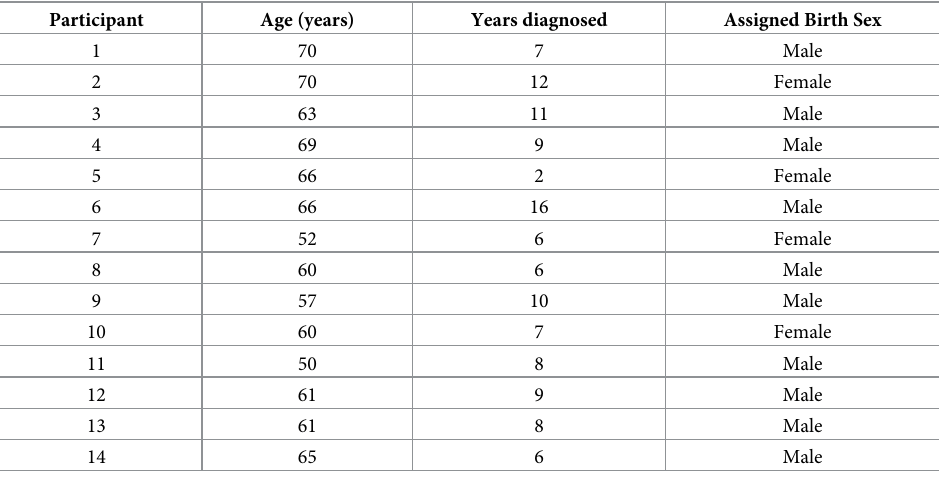
Table 1. Mass spectrometry participant demographics.